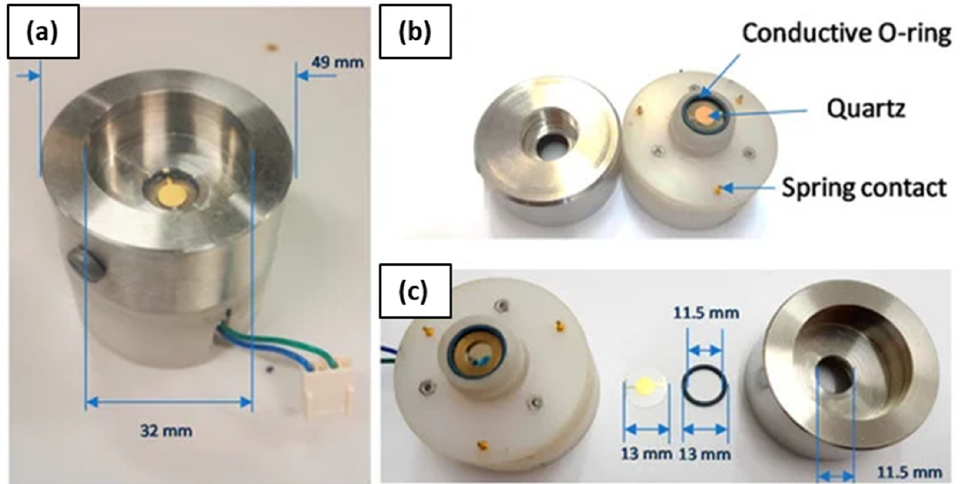
Figure 10. Measurement chamber used for the QCM tests. ( a ) shows the assembled chamber, ( b , c ) show the building blocks. ( b , c ) show the building